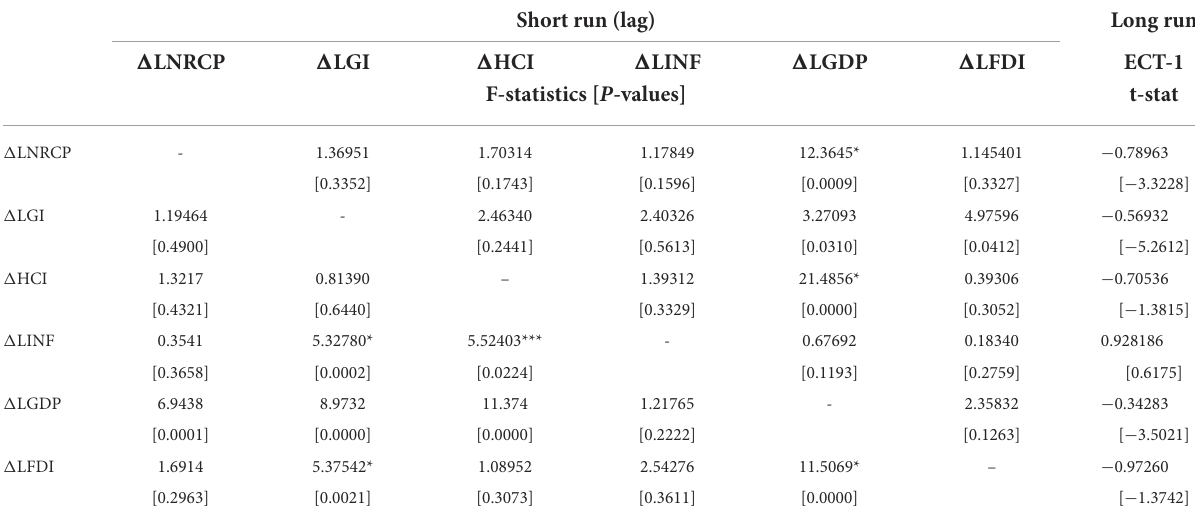
TABLE 12 Short-run diagnostic tests.